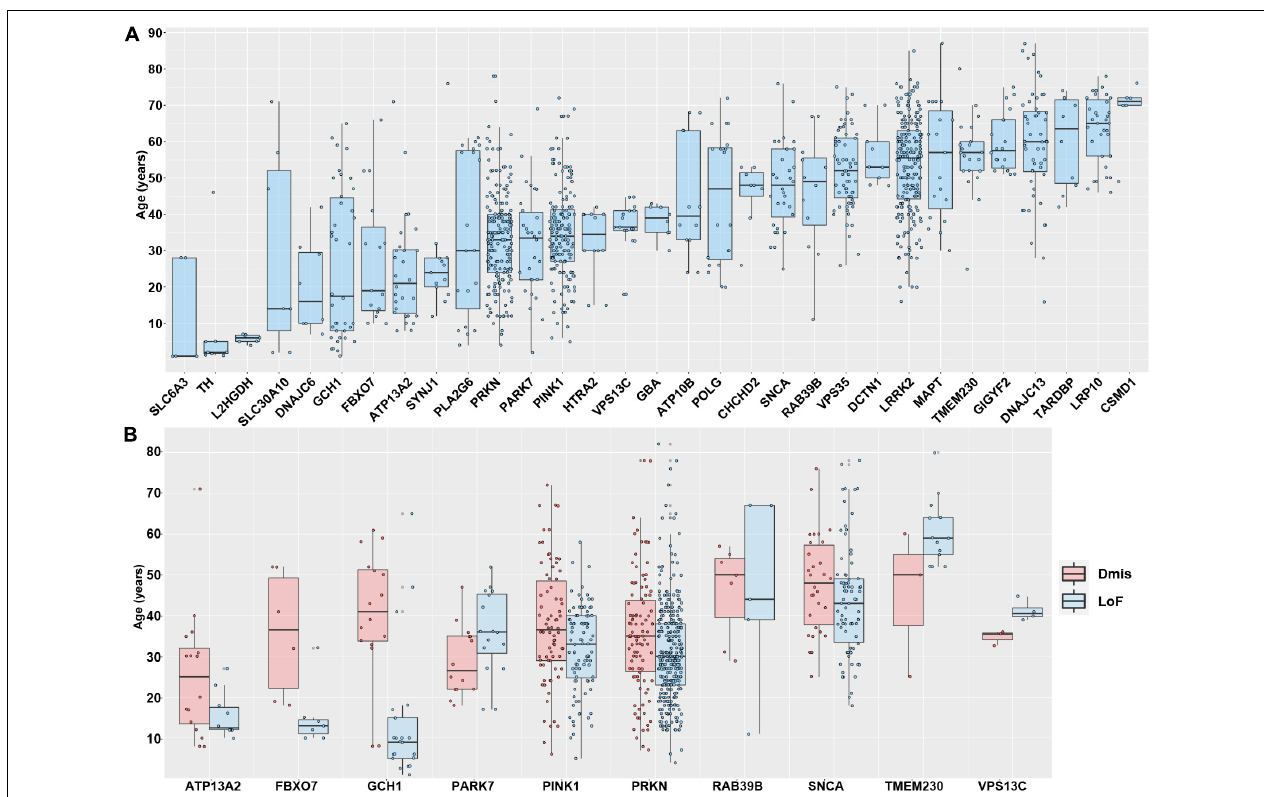
FIGURE 3 | Association between Parkinson’s disease-associated genes and age at onset. (A) The association between age at onset (AAO) and 31 Parkinson’s disease-associated genes with more than five AAO items. The genes shown are sorted according to the median AAO or each gene. (B) Association between AAO and 10 Parkinson’s disease-associated genes with more three loss-of-function (LoF) variants and deleterious missense (Dmis)